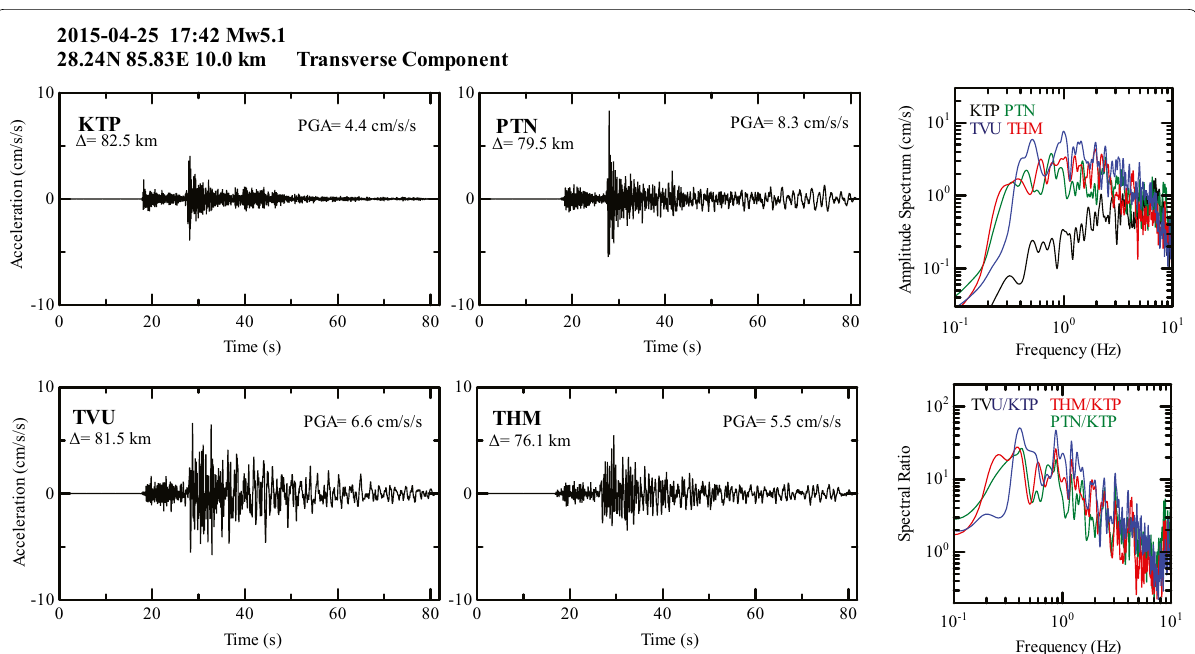
Fig. 3 Acceleration waveforms, Fourier spectra, and spectral ratios of the Mw5.1 earthquake for the transverse component. This aftershock (April 25, 2015 17:42 UTC) occurred NE of Kathmandu, near the epicenter of the mb4.9 earthquake